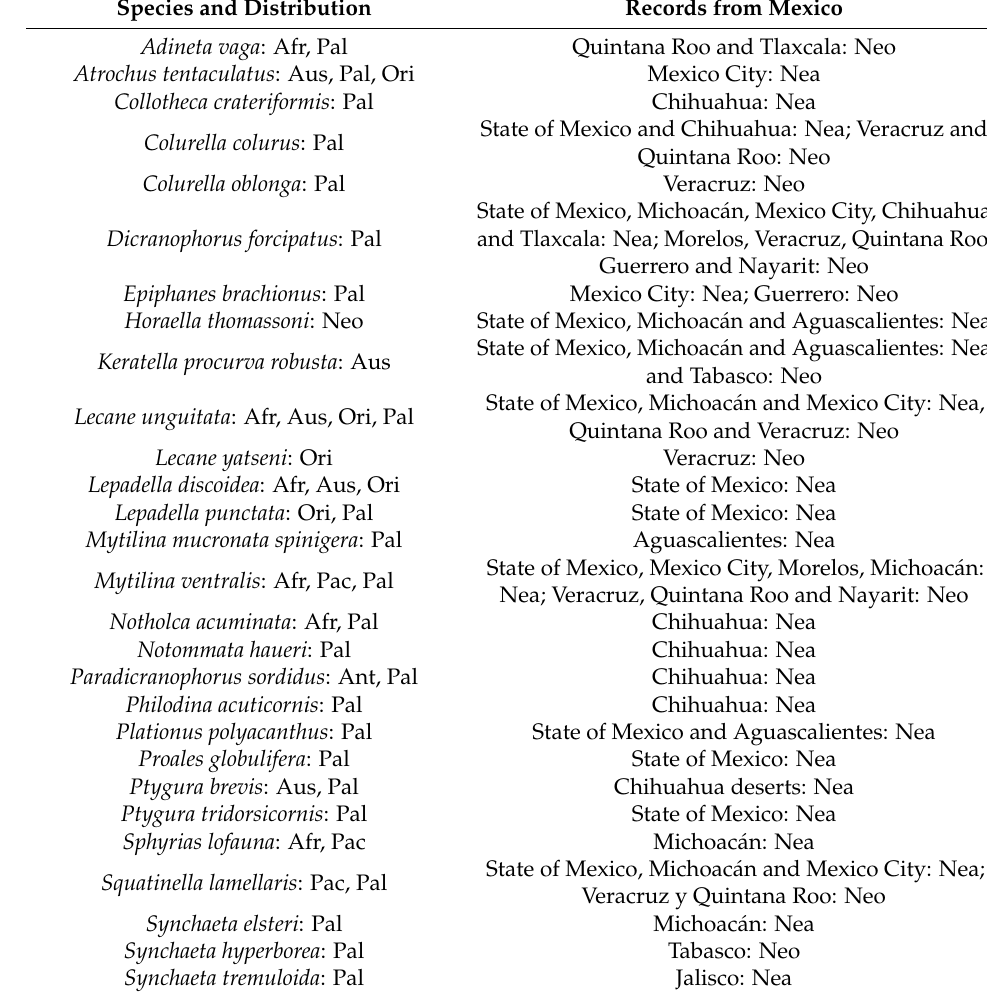
Table 5. Out of known range distribution of Rotifera recorded from Mexico. The known range from different geographical regions was based on [16], and for the national biogeographic provinces, Ref. [4] was followed. Afr: Afrotropical region; Ant: Antarctic region; Aus: Australian region; Nea: Nearctic region; Neo: Neotropical region; Ori: Oriental region; Pac: Pacific region and Pal: Palearctic region.